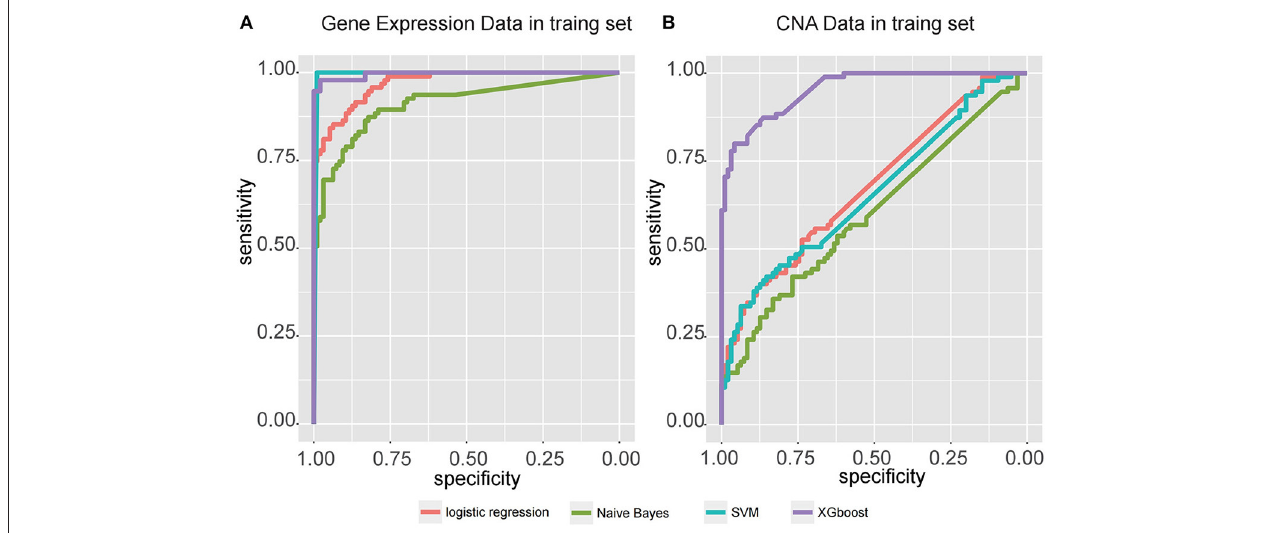
FIGURE 3 | Receiver operating characteristic (ROC) curve for four classifiers, including logistic regression, Naïve Bayes, SVM, and XGBoost, that predict the subtypes of samples from two independent datasets, (A) gene expression data from SEQC external validation cohort, and (B) CNA data from TARGET internal validation cohort.